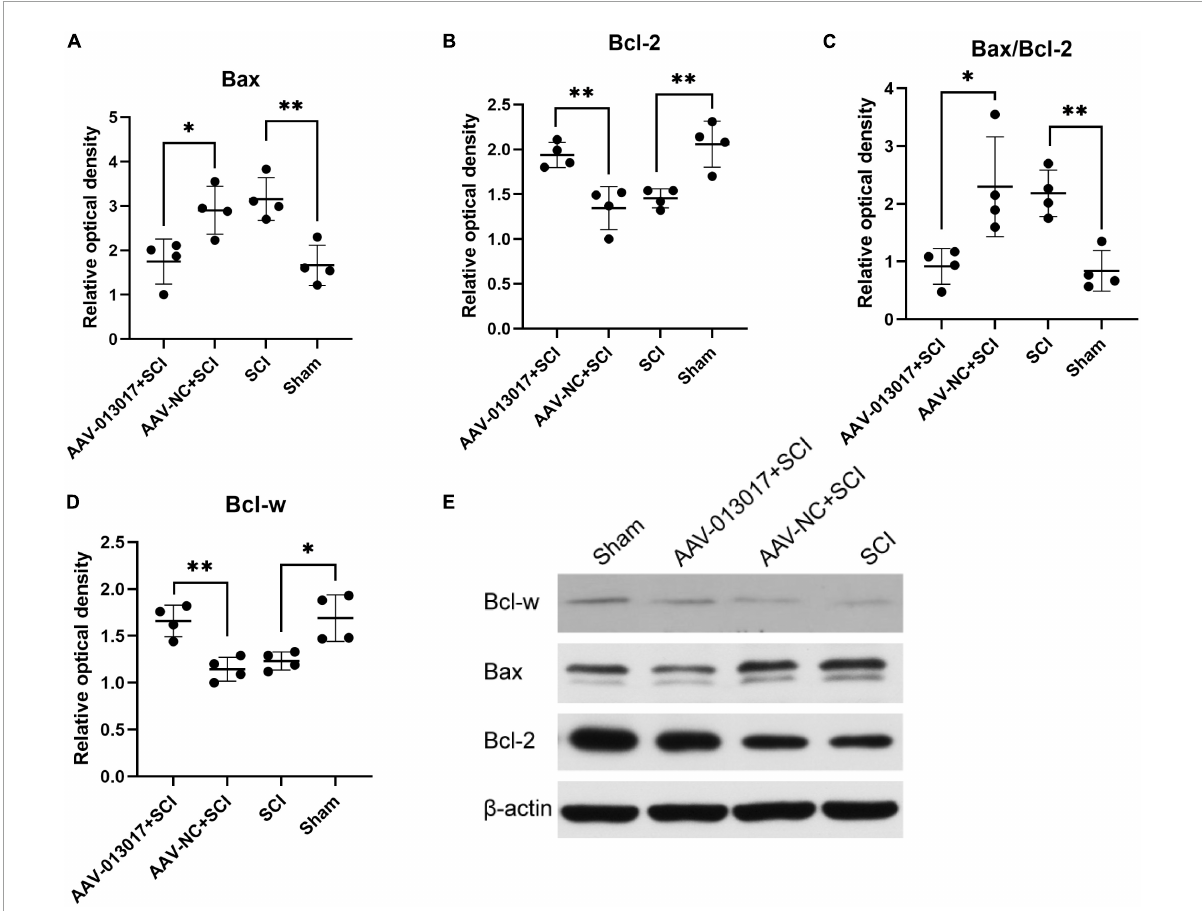
FIGURE3 Expression of relative proteins in the spinal cord at 3 days after SCI. (A) The expression level of Bax was significantly altered in all groups at 3 days after SCI ( n = 4 per group). (B) The expression level of Bcl-2 was significantly altered in all groups at 3 days after SCI ( n = 4 per group). (C) The Bax/Bcl-2 ratio, which is an apoptosis-related indicator, was significantly altered in all groups at 3 days after SCI ( n = 4 per group). (D) The expression level of Bcl-w was significantly altered in all groups at 3 days after SCI ( n = 4 per group). (E) Protein expression levels of Bcl-w, Bcl-2, and Bax in spinal cord segments in all groups at 3 days after injury ( n = 4 per group). Band optical densities were measured using Image J software. ∗ Indicates p < 0.05; ∗∗ indicates p < 0.01. Data are shown as means ± SD.